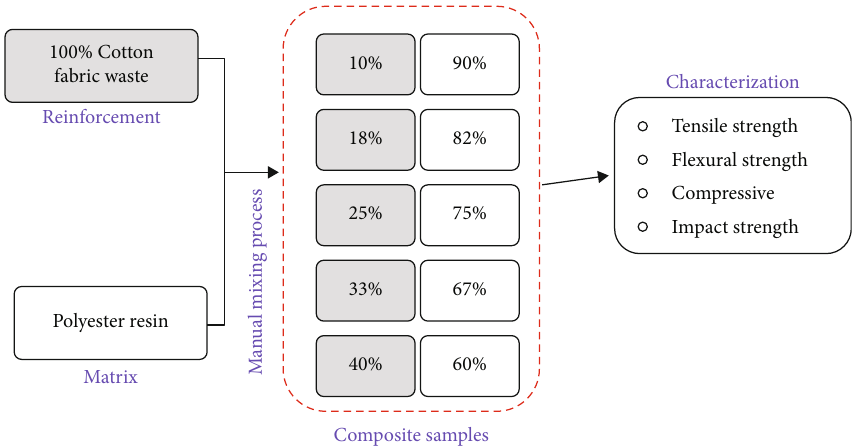
Figure 1: The general experimental procedure for this study. Experimental